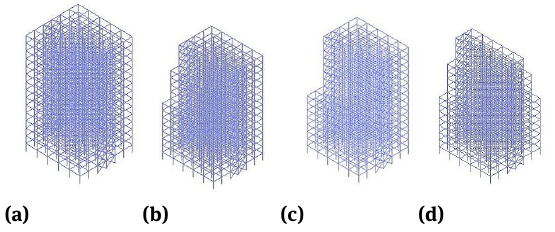
Figure 4: 15-story structures models in the OpenSees software, (a) 15story; (b) 15story – case 1; (c) 15story –case 2; (d) 15story –case